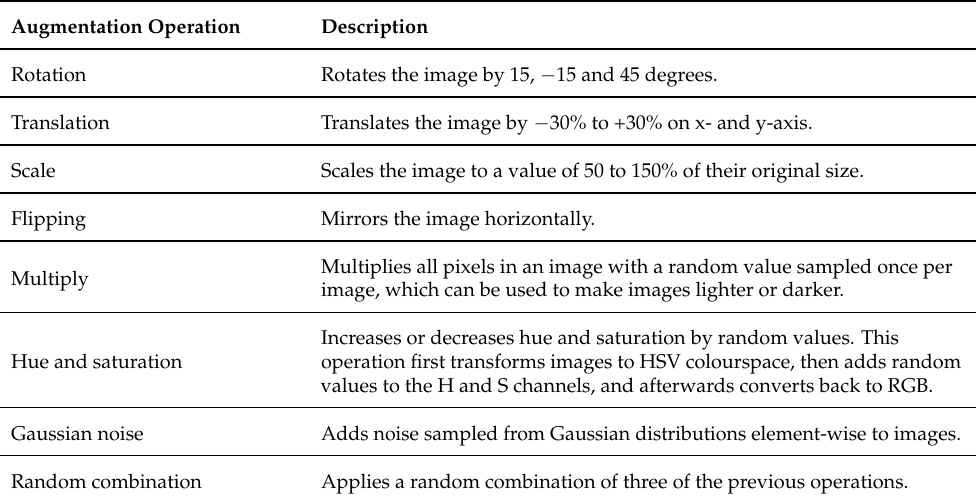
Table 3. Description of the augmentation operations used to expand the original collection of